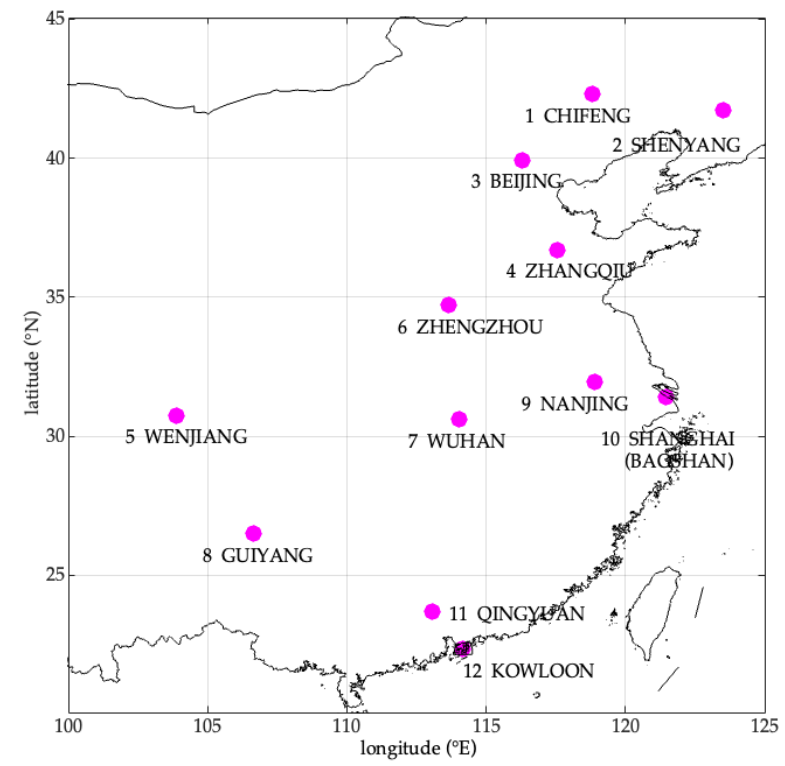
Figure 1. Distribution of the 12 IGRA stations in China selected for this research.